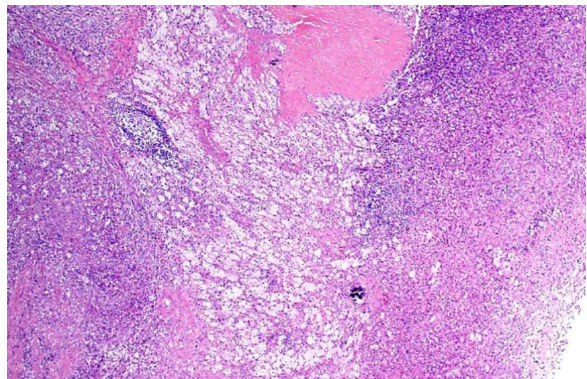
Figure 2: Photomicrograph image showing the renal paren- chyma infiltrated with dense inflammation and foam cells on low magnification, suggestive of XGP on H&E staining.